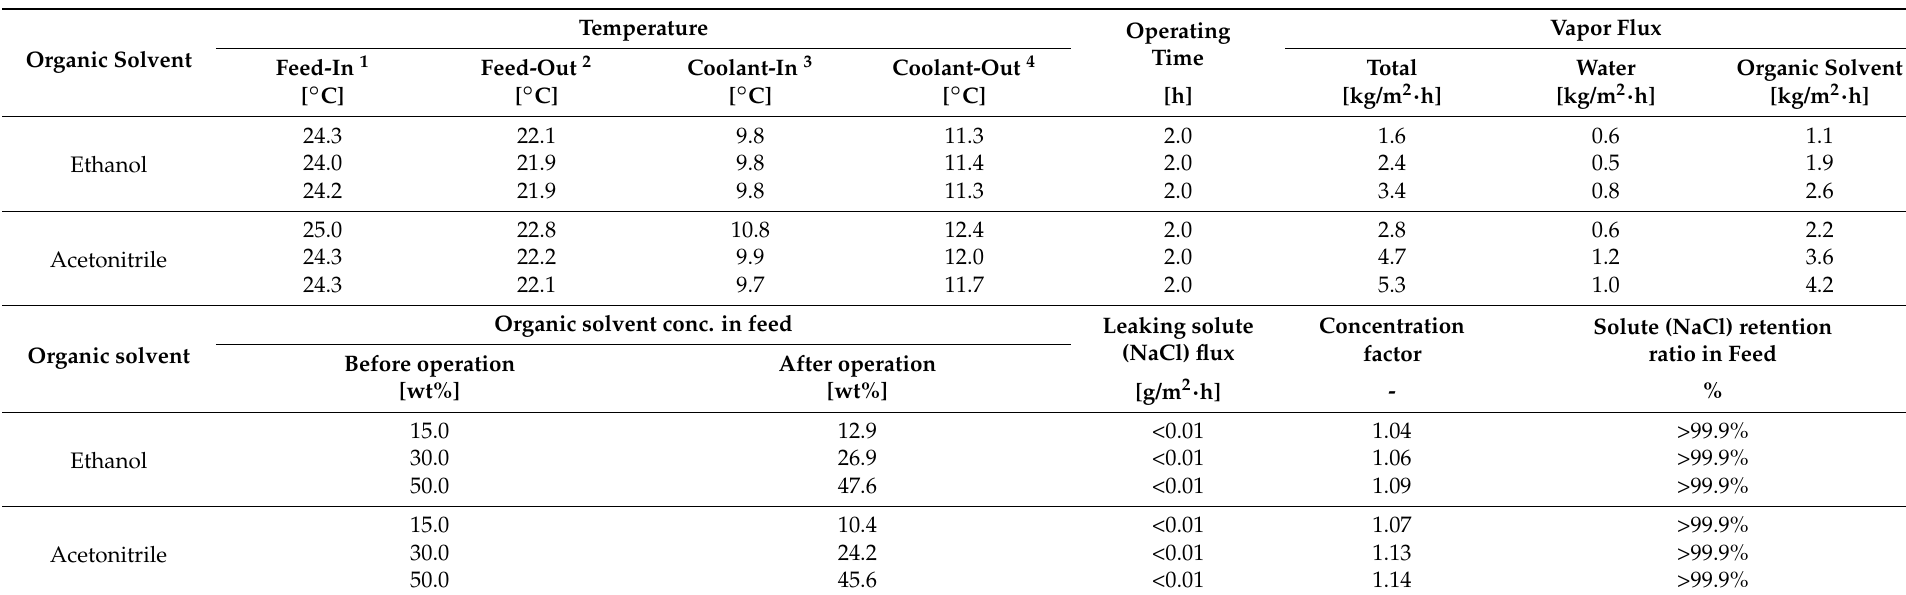
Table 7. Results of DCMD operation at about 25 ◦ C with the feed which contains 1000 ppm NaCl and various concentration of ethanol or acetonitrile.